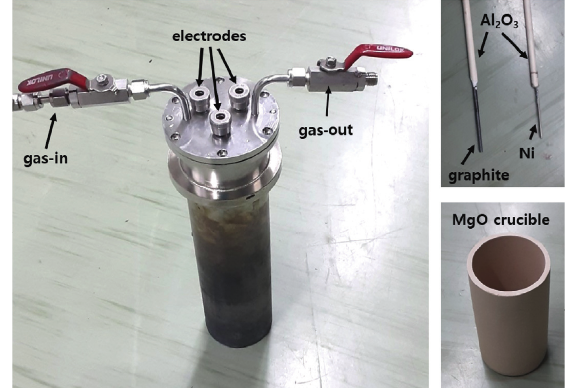
Figure 1: Configuration of electrochemical cell used for the electrochemical